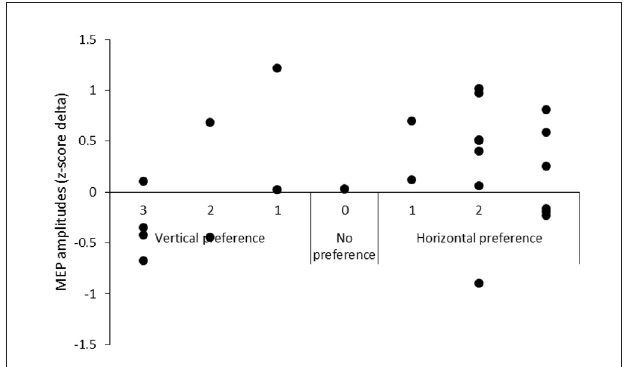
FIGURE 5 | The difference in MEP amplitude between action observation on the horizontal and vertical screen positions plotted against screen position